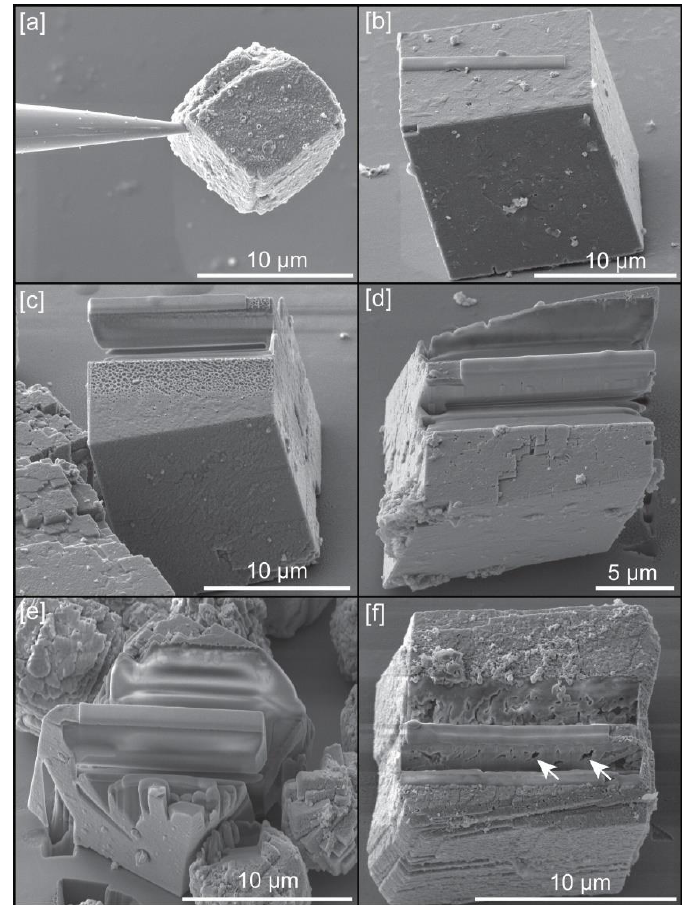
Figure 2. Example of sample preparation: ( a ) Calcite crystal lifted-out from the silicon wafer with nanomanipulator using electrostatic forces; ( b ) Example of Pt rectangle deposited on the (104) plane of calcite; ( c ) Example of wedge cut from a crystal grown with chitin hydrogel; ( d ) Example of wedge cut from a crystal grown with chitin at 0.12 mg / mL concentration of yatalase; ( e ) Example of wedge cut from a crystal grown with chitin at 1.2 mg / mL concentration of yatalase; ( f ) Example of crystal grown with chitin nanofibers; white arrows indicate voids in the wedge.